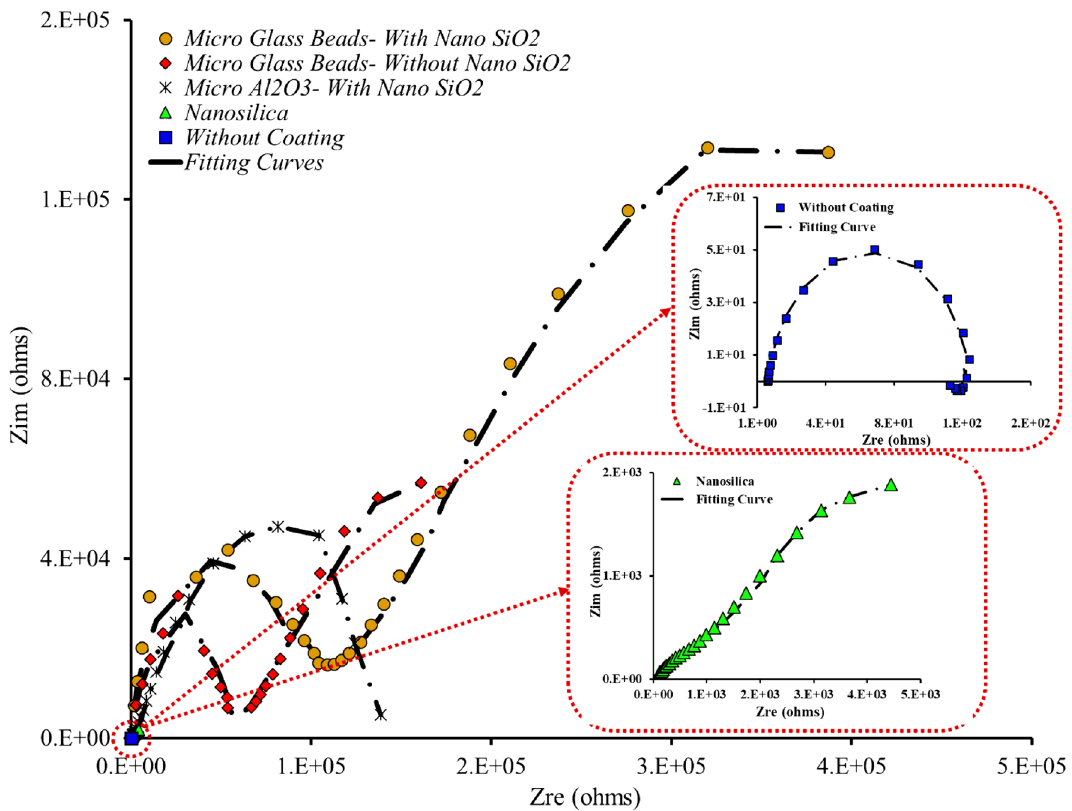
Figure 6. Nyquist plots for the investigated samples including: PTFE coating with glass beads microparticles in primer layer and SiO 2 nanoparticles in overcoat layer (circle symbols), PTFE coating with glass beads microparticles in primer layer and without SiO 2 nanoparticles in overcoat layer (diamond symbols), PTFE coating with Al 2 O 3 microparticles in primer layer and SiO 2 nanoparticles in overcoat layer (star symbol), nanosilica coating (triangle symbols), without coating (square symbols). Impedance spectra contain experimental data (scatter plot marked by symbols) and theoretical fitting curves (lines), which simulate the experimental results by means equivalent electrical